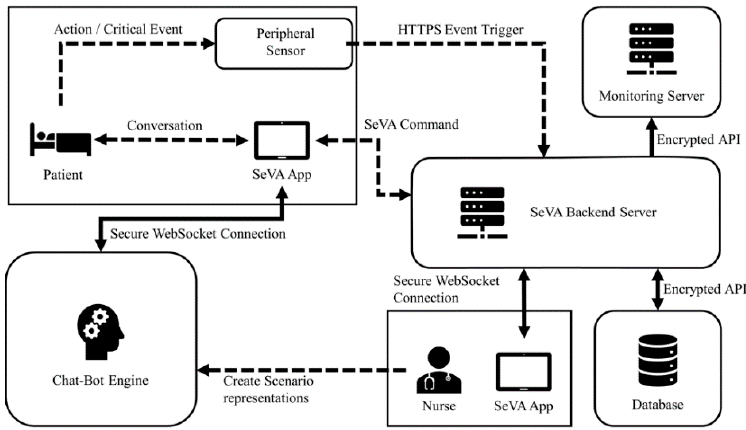
Figure 4. Coordination of activities among multiple actors within SeVa architecture.